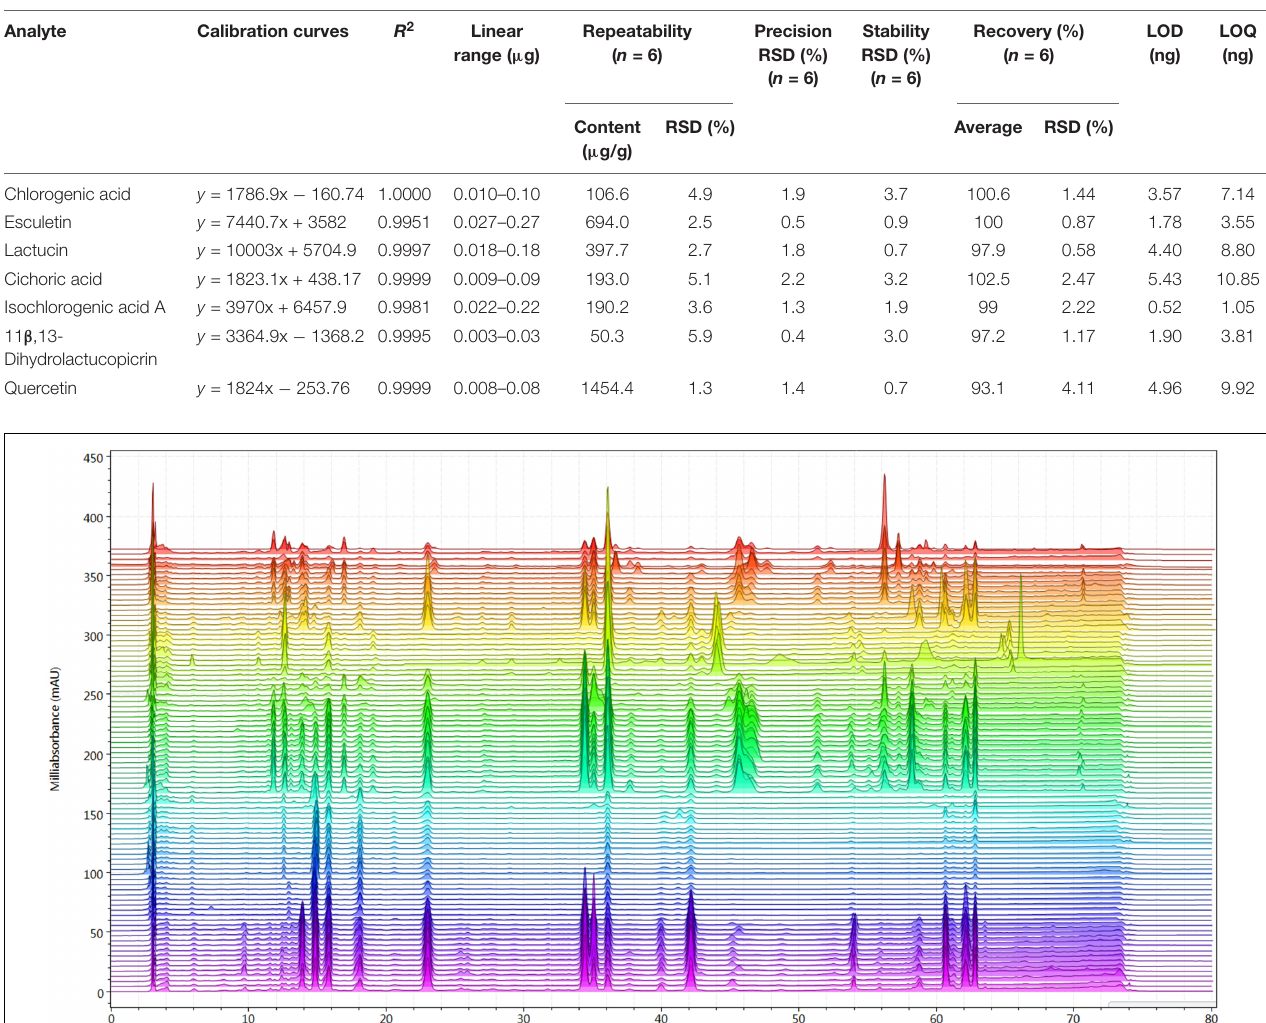
TABLE 1 | Calibration curves, repeatability, precision, stability, and recovery results of seven analytes in chicory by HPLC. Analyte